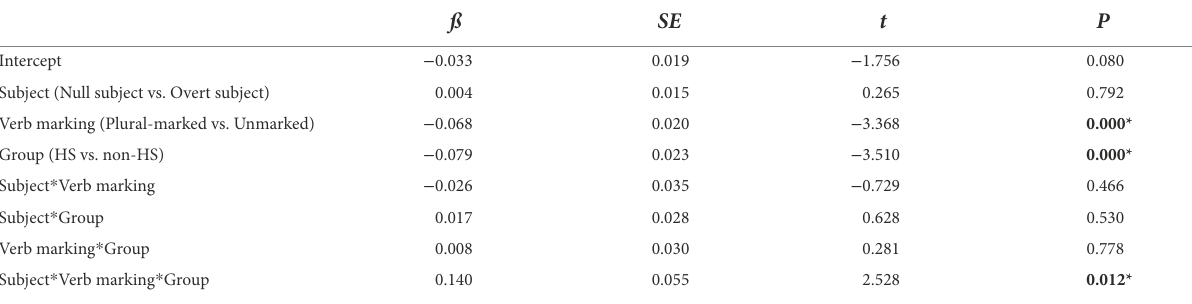
TABLE 3 Linear mixed effects model output for Region 4 (The